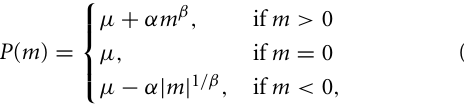
FIGURE 5 | The continuous version of the power model (Equation 7, solid line) and the quadratic model of epistasis (dashed line) applied to the chicken QTL data. The reference genotype contains as many “low” (L) alleles as “high” (H) alleles. The x-axis scales from − 4 (LL genotype at all loci) to + 4 (HH genotype at all loci). Intermediate numbers of mutations are due to genotype uncertainties when QTLs are not in total linkage disequilibrium with